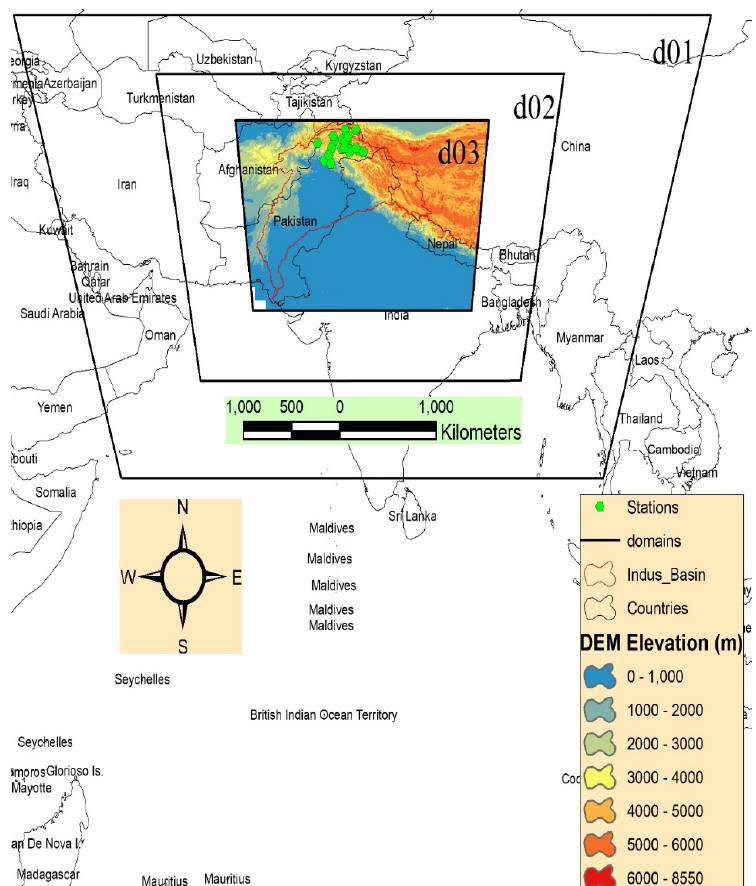
Figure 1. Configuration of the WRF model domain and topography. The study has three nested domains (d01–d03) with horizontal resolutions increasing inward from 36 km to 12 km to 4 km grid cell resolution, respectively. The elevation of the study region was derived from a 90 m resolution SRTM DEM.